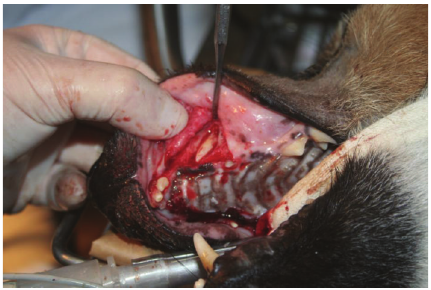
Figure 1: Dorsoventral view of the head of the maned wolf with infraorbital swellings, abscess formation, and fistulation.